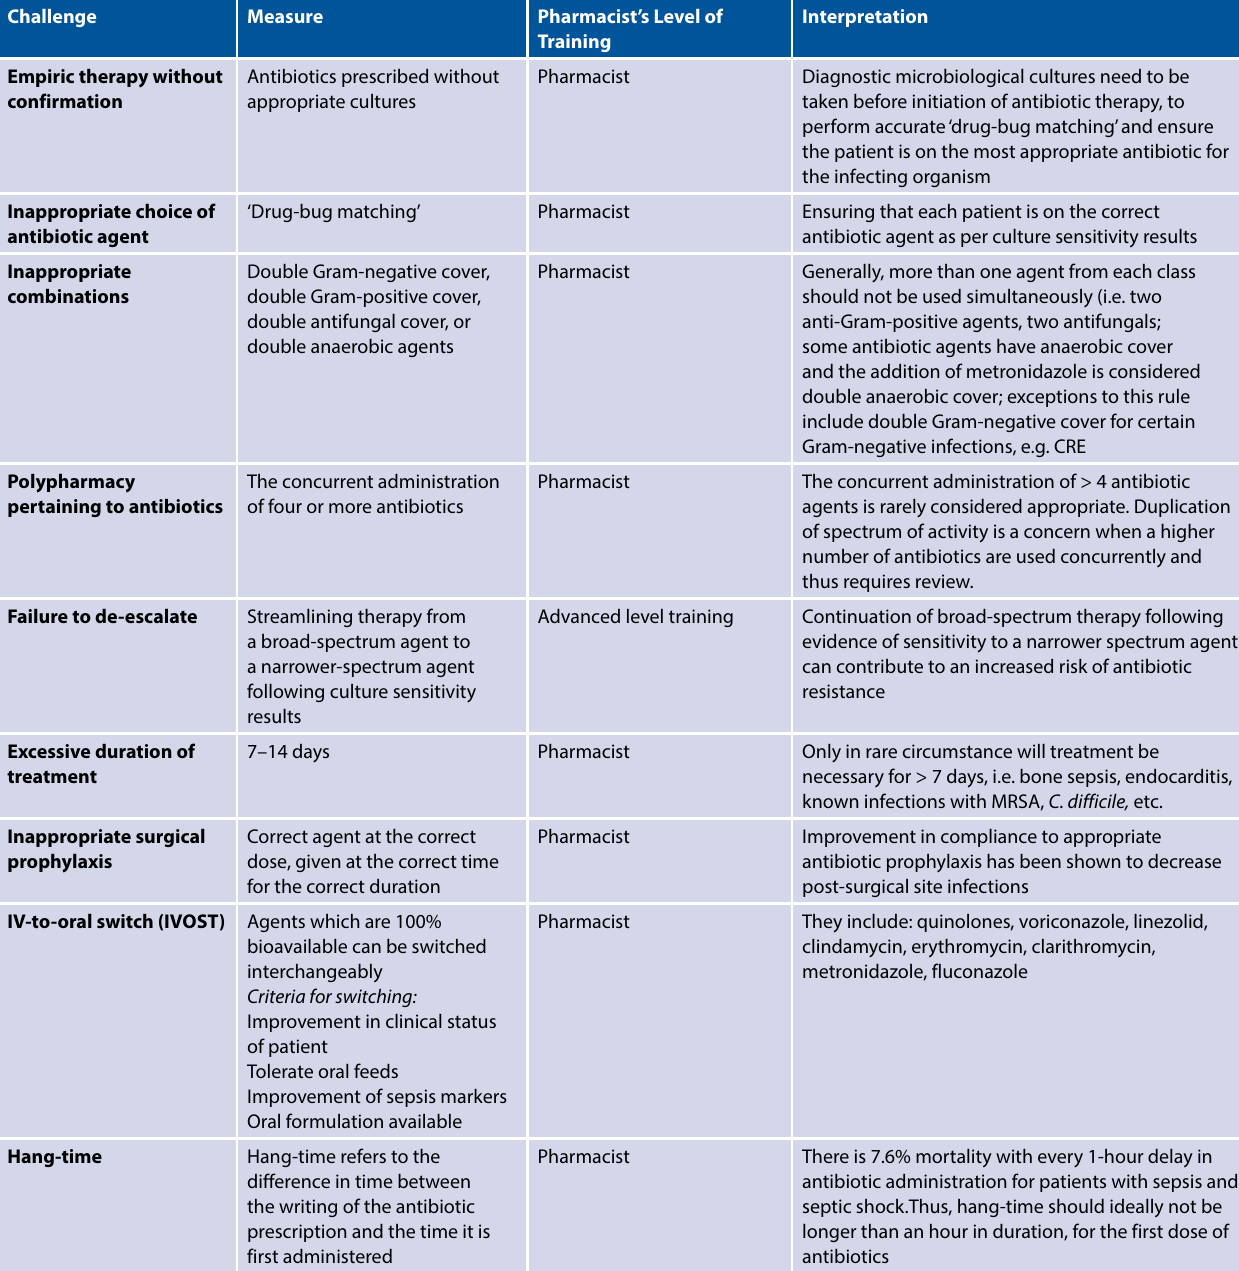
Table I. Antibiotic stewardship measures